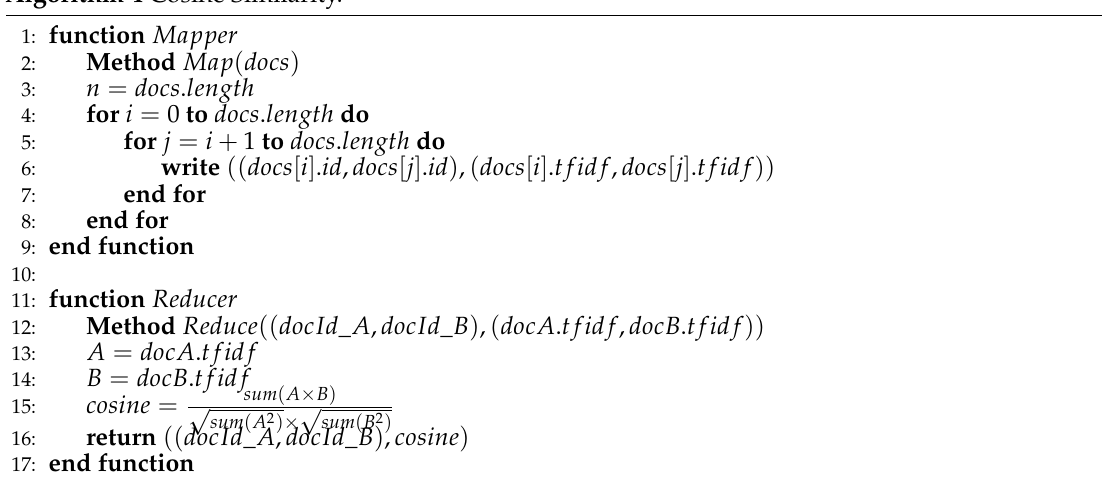
Algorithm 4 Cosine Similarity.